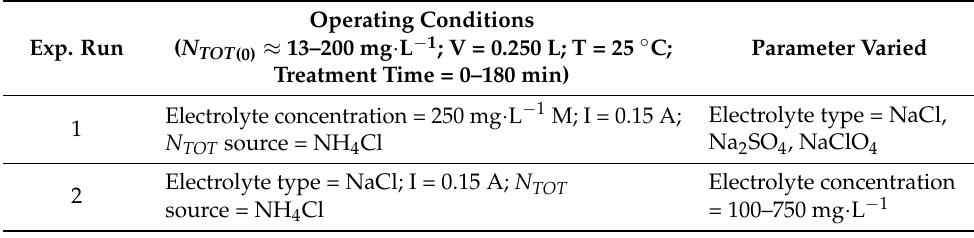
Table 1. Experimental conditions.